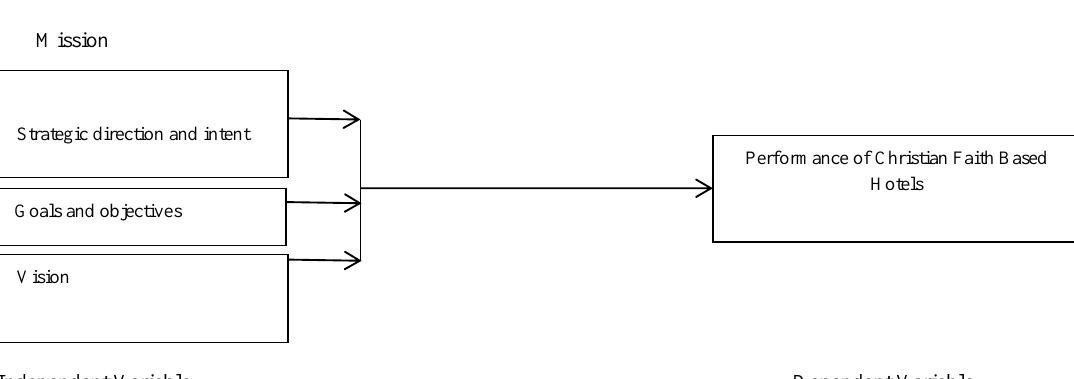
Performance of Christian Faith Based